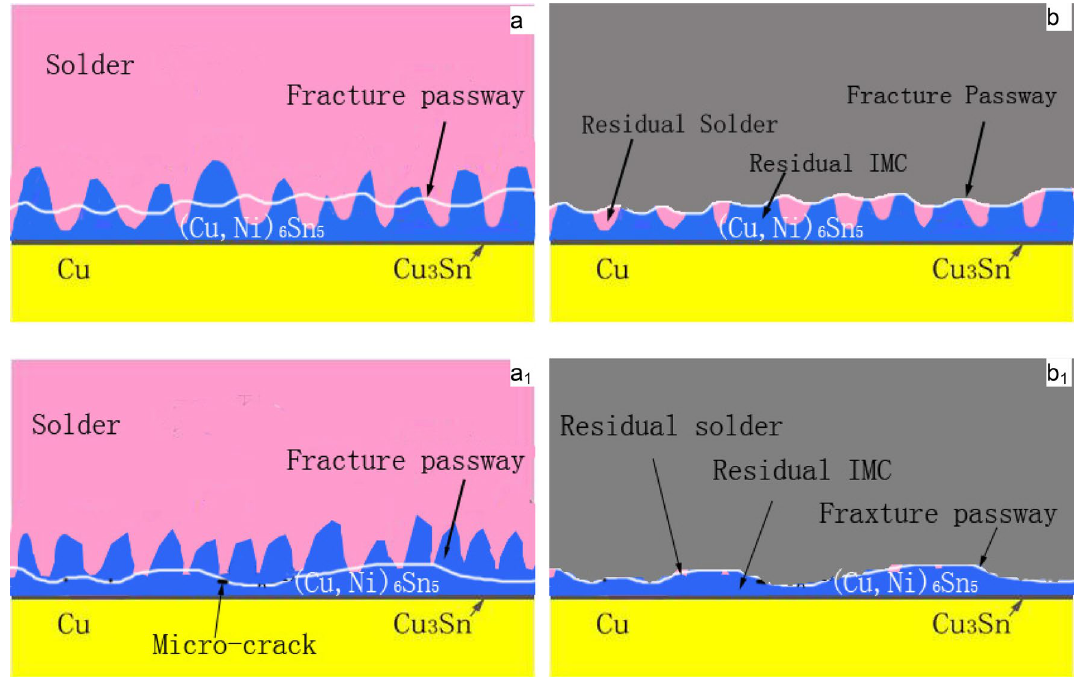
Figure 16. Failure modes of solder joints: ( a , b ) solder/IMC mode, ( a 1 , b 1 ) IMC mode. ( a , a 1 ) Fracture pathway, ( b , b 1 ) Side view of shear